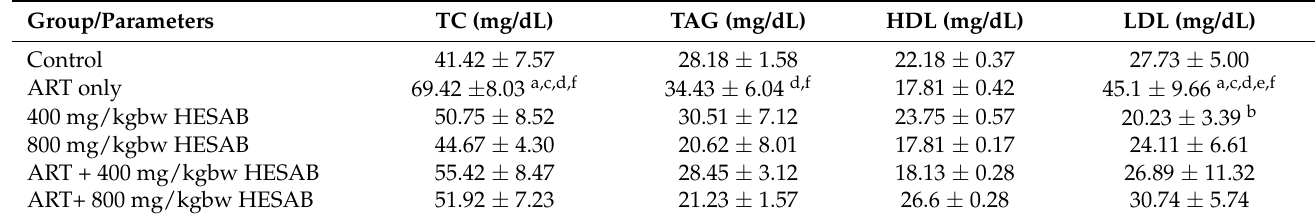
Table 2. Effects of HESAB on serum lipid profile.